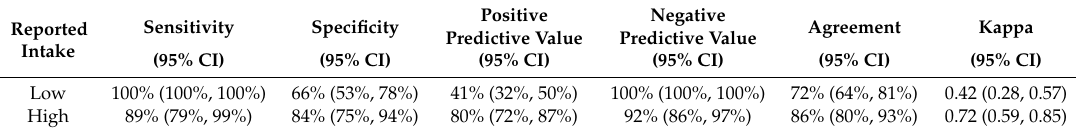
Table 5. Sensitivity, specificity, positive predictive value, and negative predictive value based on